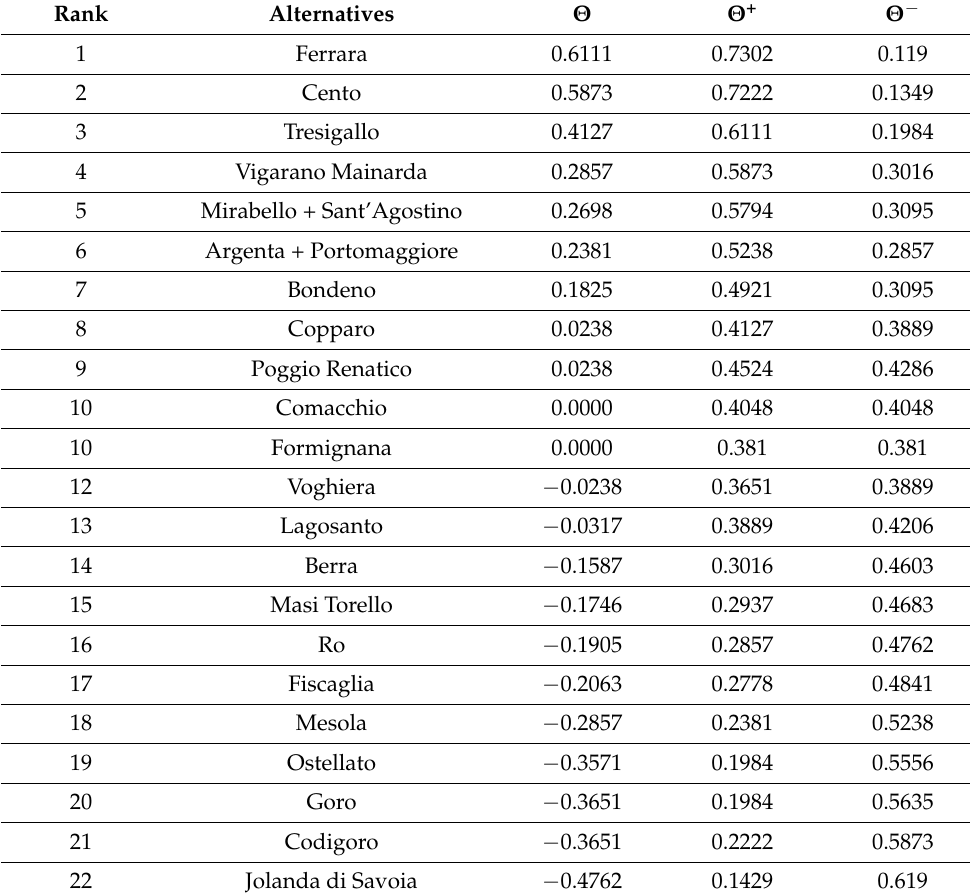
Table 4. Ranking of alternatives for the usual preference